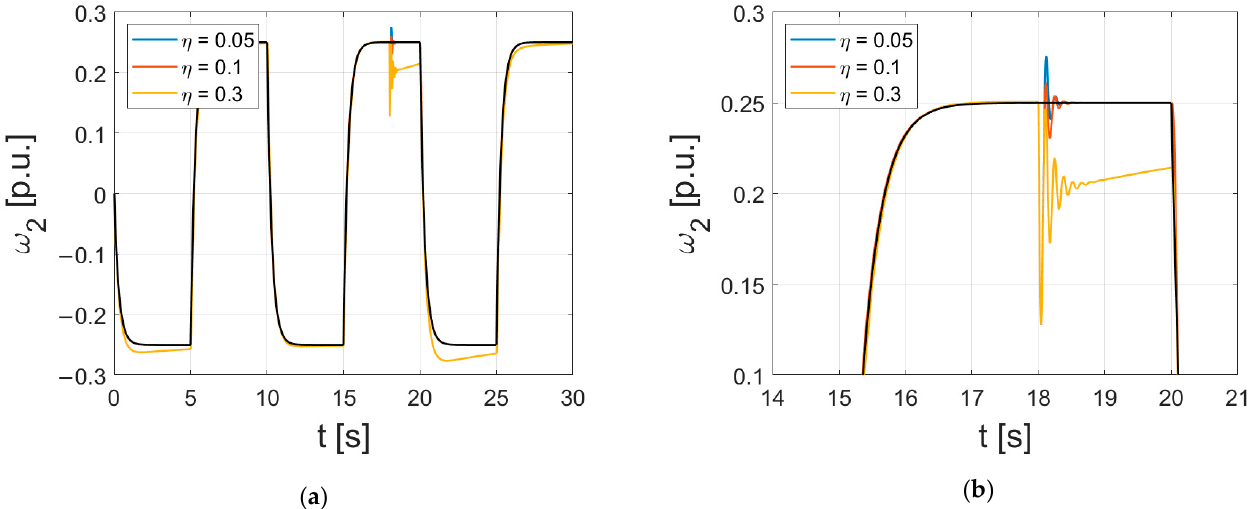
Figure 9. The impact of the change of the learning coefficient: ( a ) the overview of the simulation run; ( b ) a zoom-in presenting the final stage of the simulation.